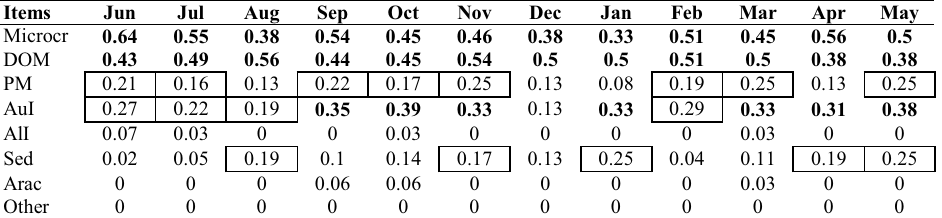
Table 4. Index of alimentary importance for E. trilineata juvenile food categories. Bold numbers = main item; framed numbers = addition item; simple numbers = accidental item.